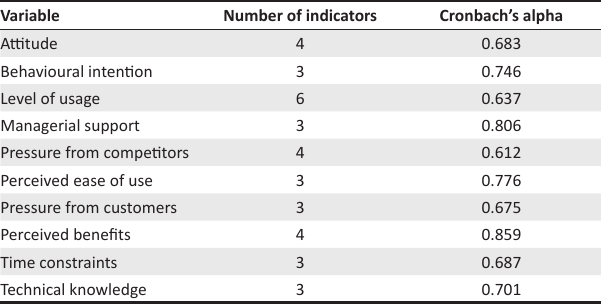
TABLE 2: Reliability results.